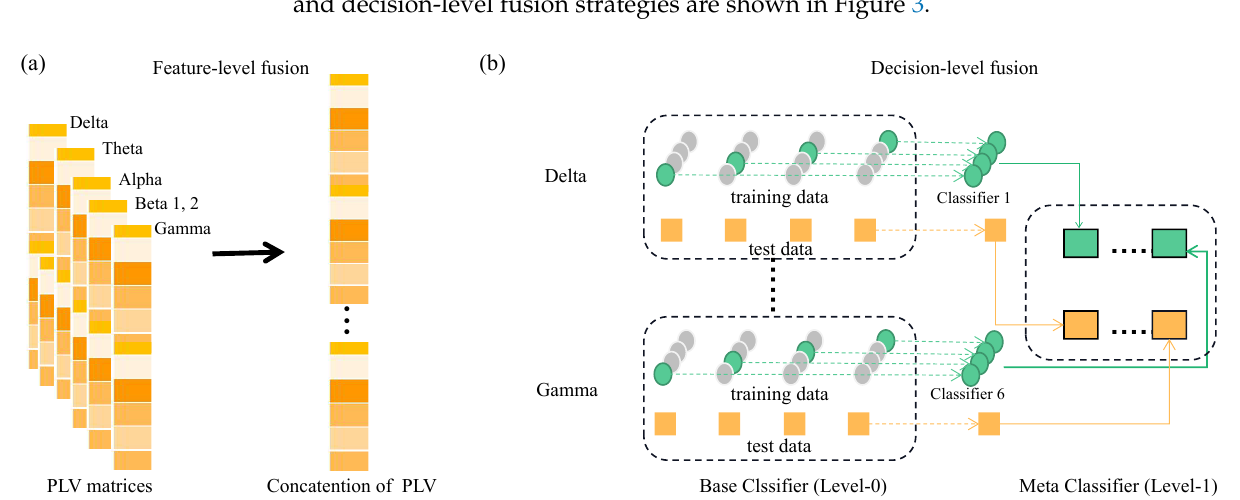
Figure 3. Schematic diagram of fusion strategy. ( a ) indicates the feature-level fusion and ( b ) is the decision-level fusion using